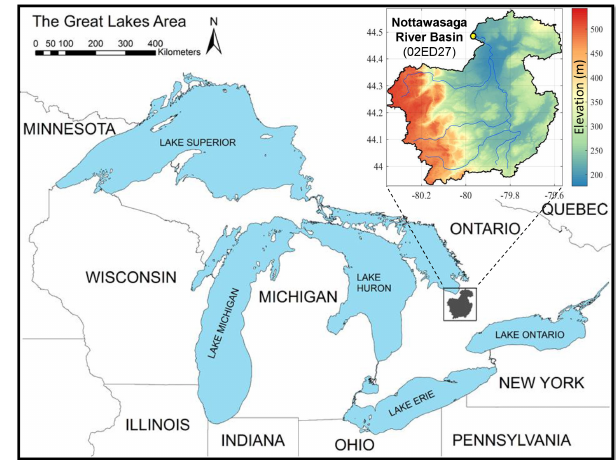
Figure 1. The Oldman River basin (b) , located in the Rocky Mountains in Alberta, Canada, flows into the Saskatchewan River basin (a) .